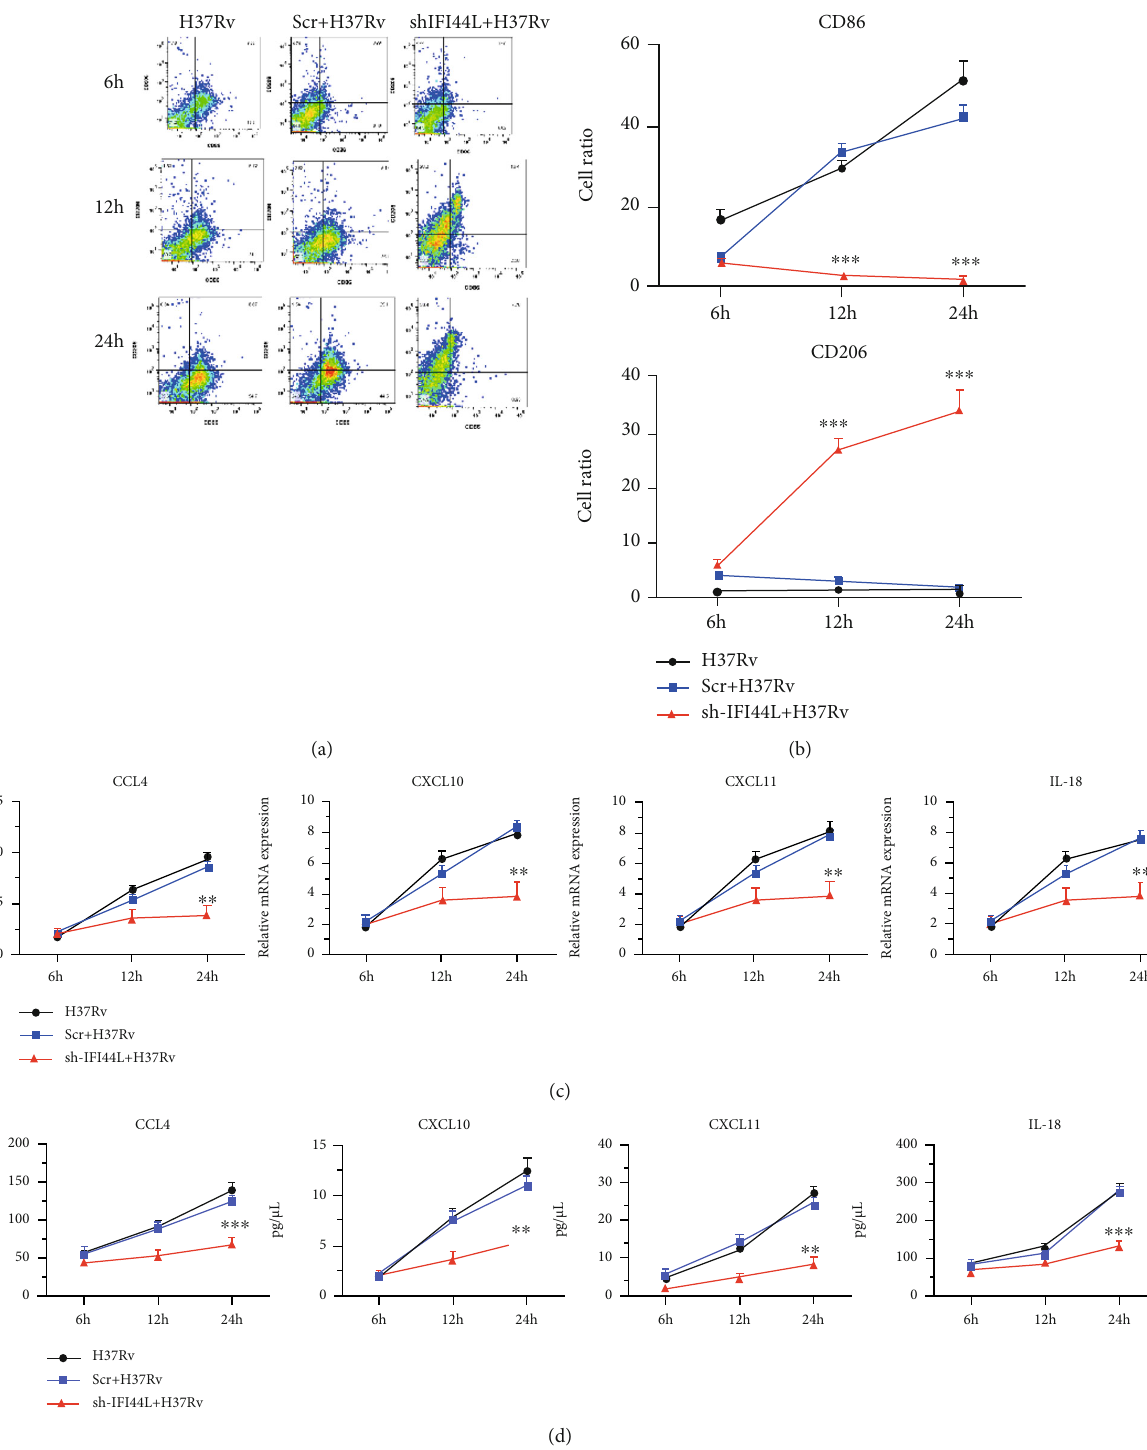
Figure 4: IFI44L promoted macrophage di ff erentiation and in fl ammatory cytokine secretion. (a, b) CD86 and CD206 expressions analyzed by fl ow cytometry. (c, d) CCL4, CXCL10, CXCL11, and IL18 expression of M. tuberculosis H37Rv-infected cells with shRNA-IFI44L augmented by qPCR and ELISA at 6, 12, and 24h. Values are presented as levels relative to β -actin. ∗∗ P < 0 : 01 ; ∗∗∗ P < 0 : 001